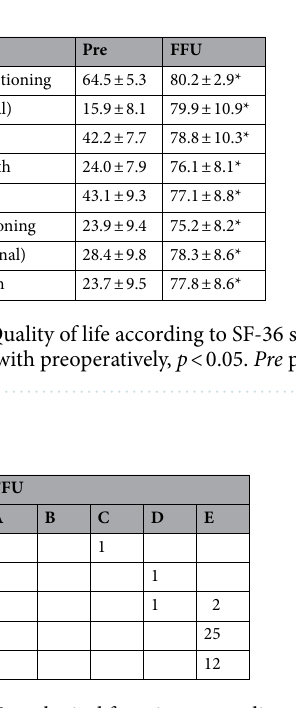
Table 4. Neurological functions according to the ASIA impairment scale for preoperative and postoperative follow-up. Pre preoperative, FFU final